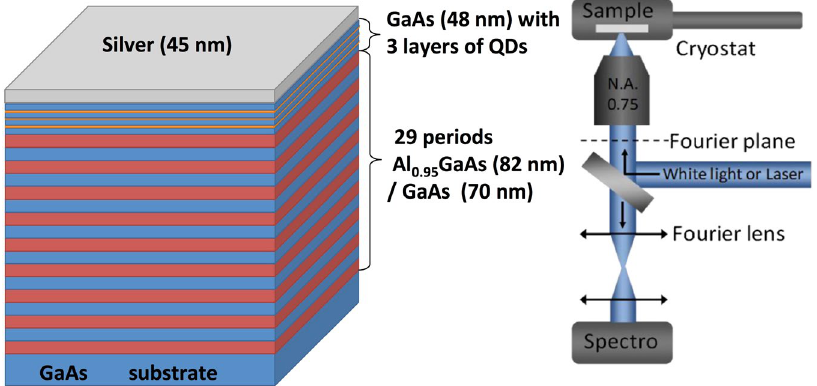
Figure 1. Scheme of the structure and experimental